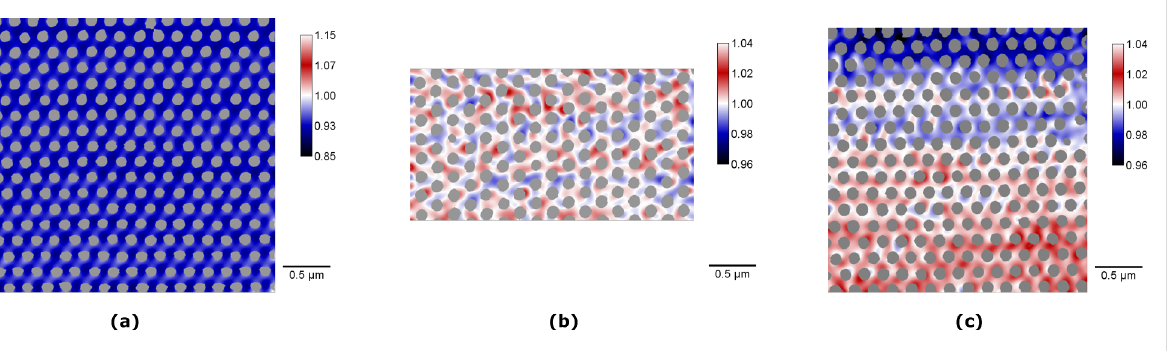
Figure 11: Fe L 3 edge XMCD contrast of X-ray micrographs under normal incidence of a hexagonal antidot lattice with a = 200 nm antidot periodicity and d = 100 nm antidot diameter in a t = 20 nm thick Fe film (cf. Figure 2). An in-plane magnetic field of 240 mT is applied in horizontal direction, i.e., along the nn-direction for images (a) and (c) and along the nnn-direction for image (b). The positions of the holes are indicated as grey overlays. While panels (a) and (c) show the same structural orientation, panel (a) exhibits a homogeneously magnetized area and (c) features a domain wall. Reproduced with permission from [57] under CC-BY 3.0 license, copyright 2015 IOP Publishing Limited.